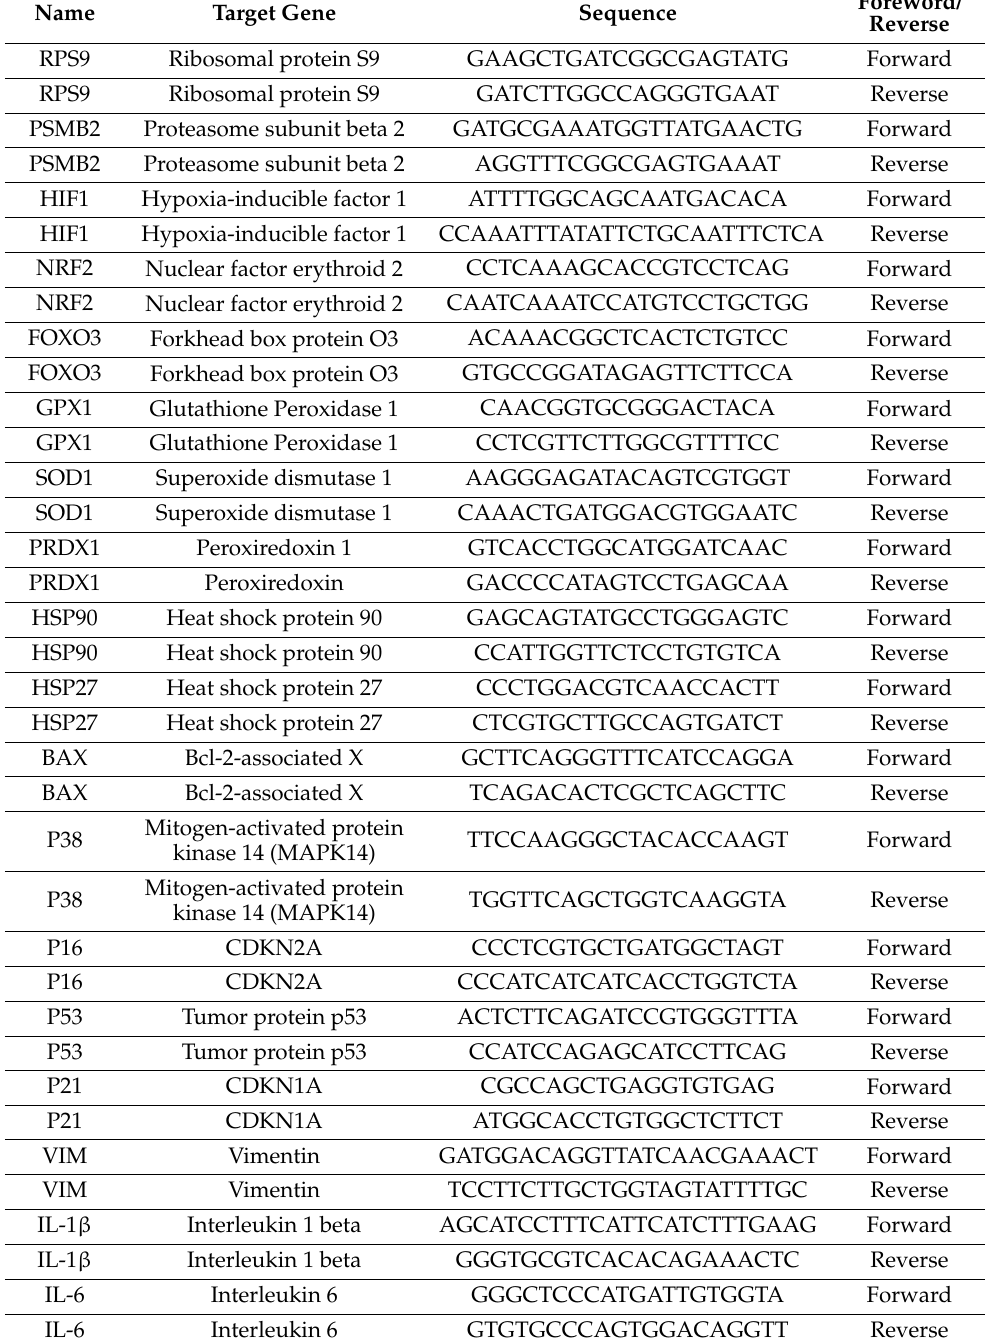
Table 1. Primers used for